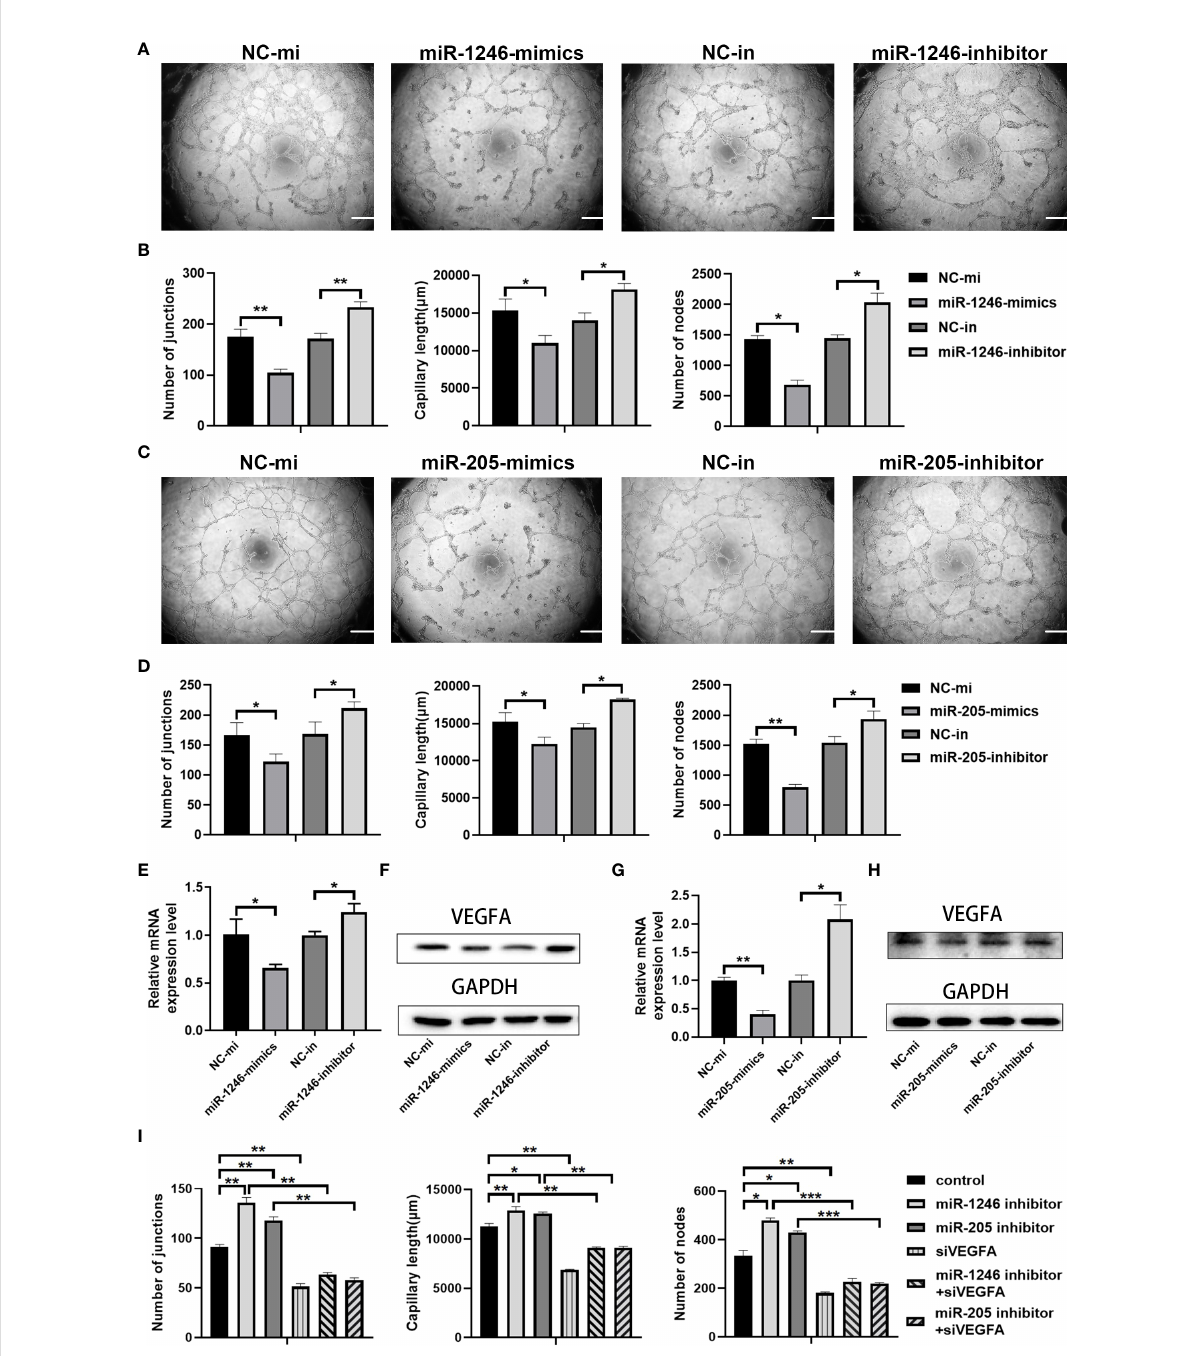
FIGURE 6 miR-1246 and miR-205 inhibit tube formation by vascular endothelial cells via the suppression of VEGFA expression. (A) Images of tube formation by HUVECs at 24 h after transfection with miR-1246 mimics or miR-1246 inhibitors or corresponding controls (NC-mi or NC-in). (B) Quanti fi cation of the numbers of junctions, capillary tube length and nodes in the network structures of HUVECs in (A. C) Images of tube formation of HUVECs at 24 h after transfection with miR-205 mimics or miR-205 inhibitors or corresponding controls (NC-mi or NC-in). (D) Quanti fi cation of the numbers of junctions, capillary tube length and nodes in the network structures of HUVECs in (C) . (E – H) Expression of VEGFA analyzed by qRT-PCR (E, G) and Western blot (F, H) in HUVECs at 24 h after transfection with miR-1246 mimics or inhibitors (E, F) or miR-205 mimics or inhibitors (G, H) or corresponding controls (NC-mi or NC-in) and quanti fi cation of the expression levels of VEGFA protein shown in Supplementary Figure 6. (I) Quanti fi cation of the number of junctions, capillary tube length and nodes in the network structures of tube formation (shown in Supplementary Figure 7) by HUVECs at 24 h after transfection with the following conditions as indicated: control vehicles, miR-1246 inhibitor, miR-205 inhibitor, siVEGFA, miR-1246 inhibitor plus siVEGFA, and miR-205 inhibitor plus siVEGFA, All experiments were performed three times, and error bars represent means ± SD; P values are indicated with “ * ” , * indicates P<0.05, ** indicates P<0.01, *** indicates